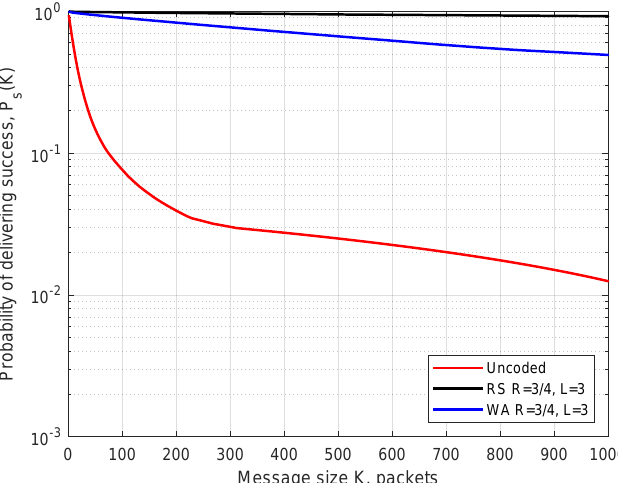
Figure 12. SDF for the entire session. Simulation results for the WA codes of different rates used over the entire session.